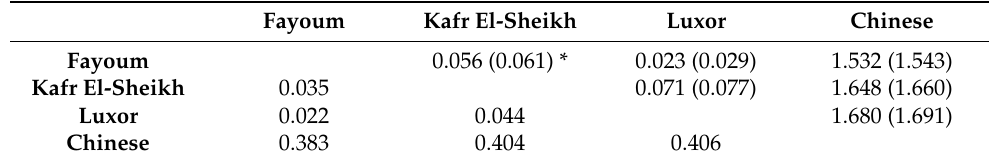
Table 6. Reynolds genetic distance (above diagonal) and pairwise F ST (below diagonal) estimates for the 11 microsatellite loci between the four studied goose populations.